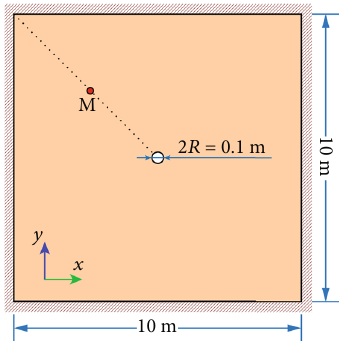
Figure 4: 2D geometry used in both simulations.